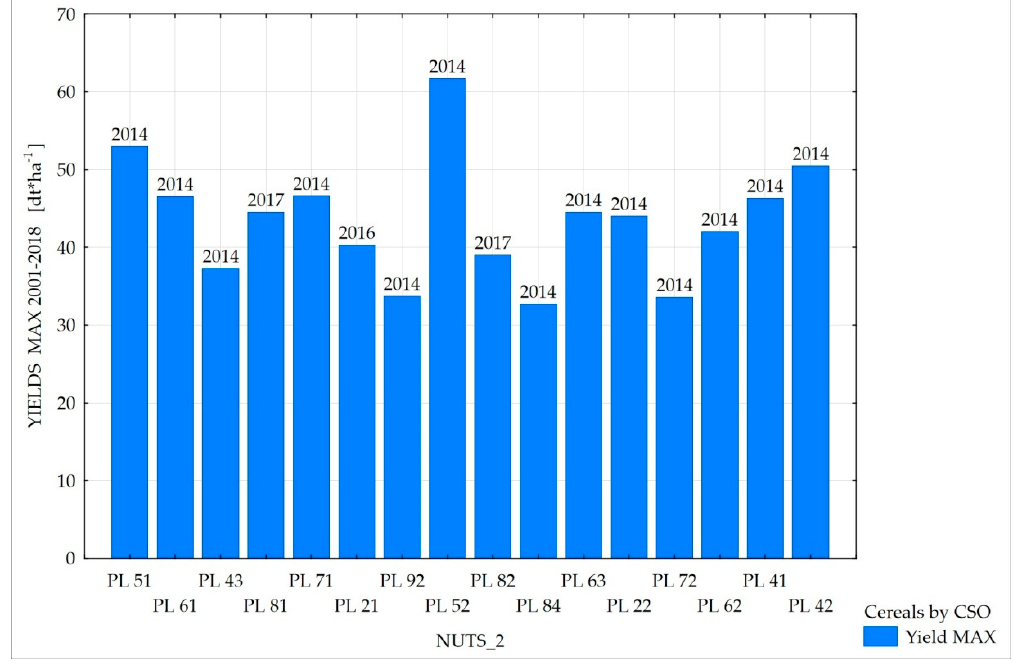
Figure 19. Maximum yields for particular voivodeships in Poland.